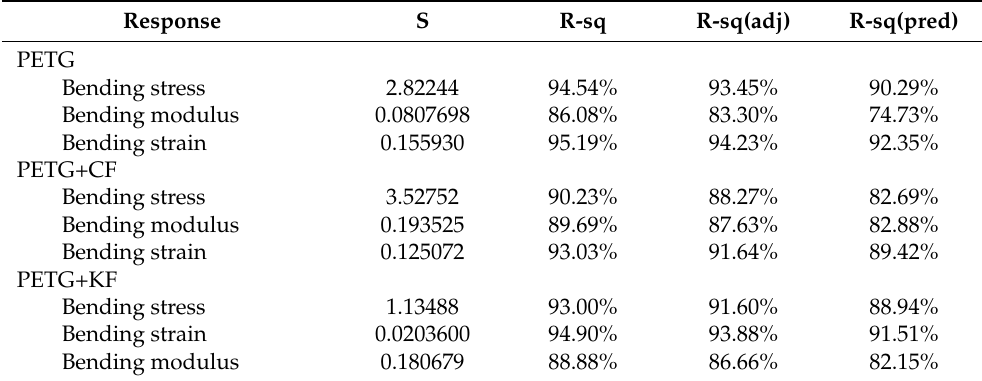
Table 10. Model summary for all